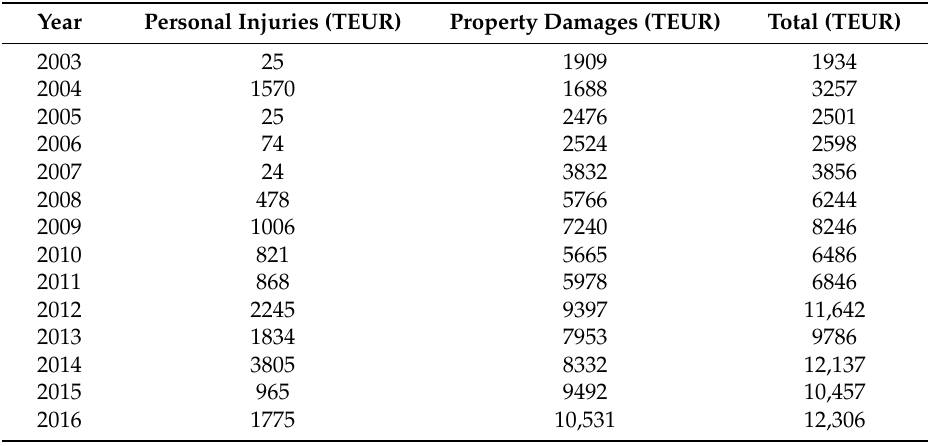
Table 4. The costs of wild boar-vehicle accidents in Sweden from 2003 to 2016. Costs are calculated from Table 1 and a standard cost of EUR 2222 for property damages. TEUR = thousand